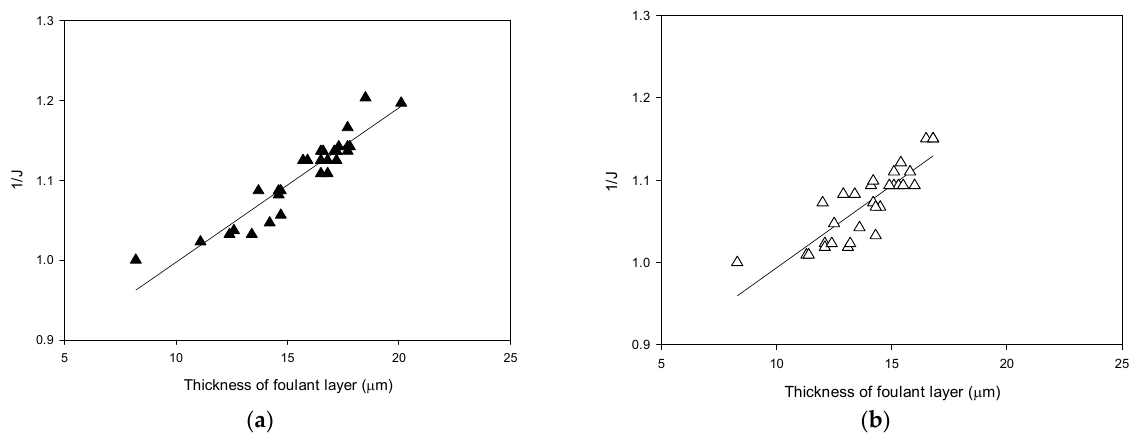
Figure 12. Correlation between the foulant layer thickness and the reciprocal of fl ux for intermi tt ent